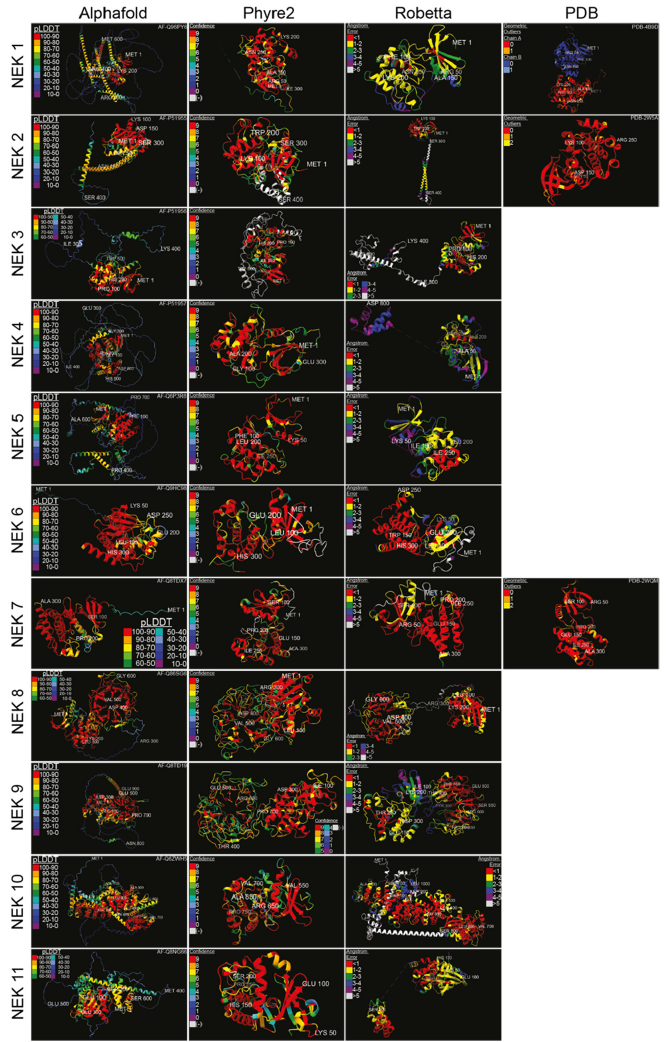
Figure 3. Structure predictions and known crystal structures of the human Nek proteins. Amino acid sequences were input into Robetta’s RoseTTAFold [29] and Phyre2 ′ s Intensive [30] algorithms, with the resulting structures visualized in the first quarter of 2022. Amino acids were truncated from the C-terminus if necessary. Alphafold [31] and PDB structures were from [32] for Nek1 kinase domain, [33] for Nek2, and [34] for Nek7, with the accession numbers displayed. Structures were colour-coded according to the source’s measurement of error. High-error sequences were removed for visual clarity. Structures were visualized, colour-coded, and imaged with ChimeraX [35] (pLDDT = per-residue confidence score; (-) = outside of confidence